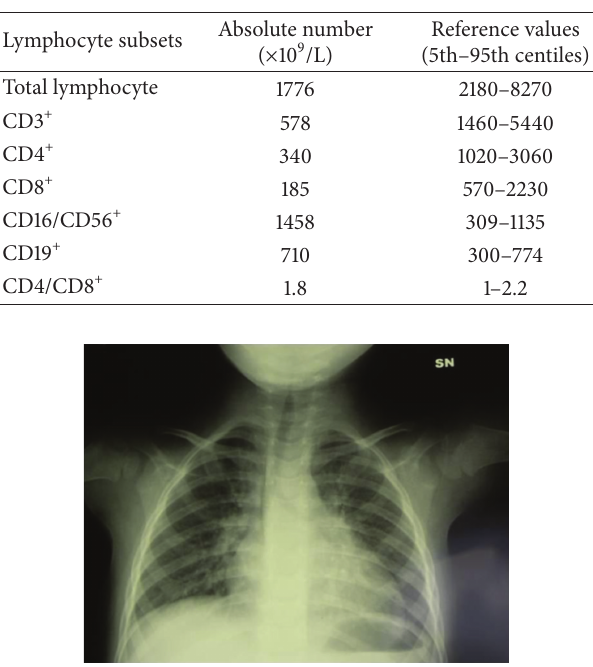
Table 1: Lymphocyte subsets. A low count of CD3 + cells and of CD4 + and CD8 + T cells with an increase of CD16/CD56 + cells (NK cells) and a normal number of B cells (CD19 + ) was found in our patient.